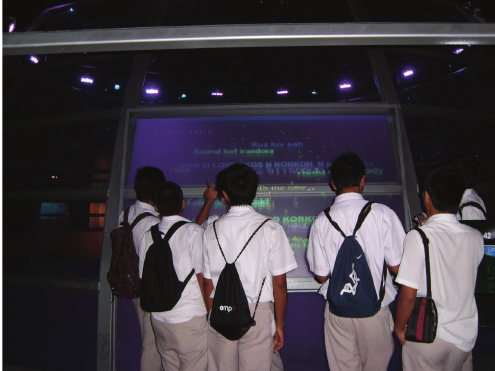
Figure 5: School children are interacting with BlogWall at Singa- pore Science